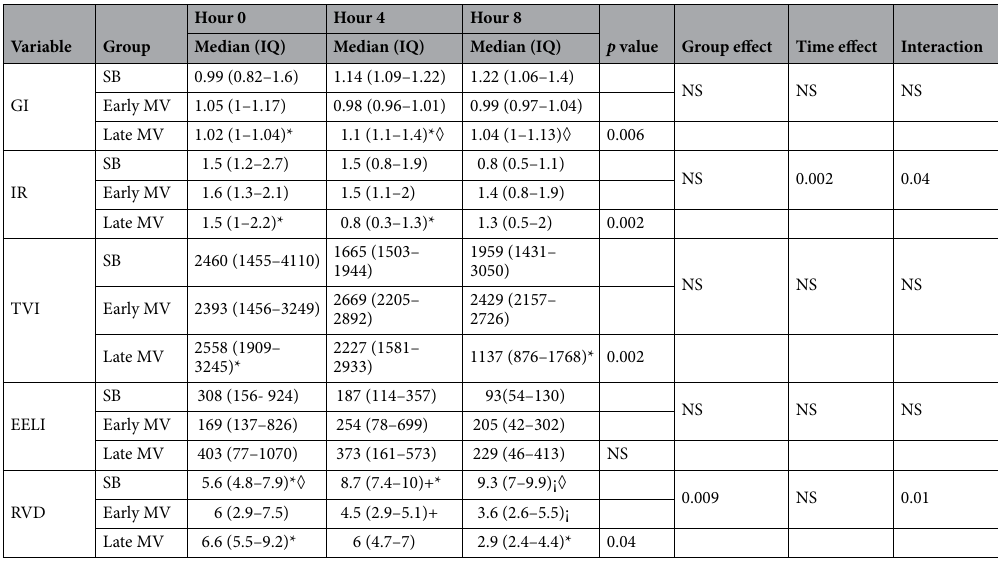
Table 4. EIT parameters. p value corresponds to Friedman test to the Late MV group, (* and ◊) correspond to p < 0.05 for multiple comparisons. The interaction, group effect, and time effect were estimated between SB and Early MV groups, using the GLMM for each variable. Posthoc analysis was done using the Tukey test. The uppercases * and ◊, denote p < 0.05 in pairwise comparisons time within each group. The “+” and “¡” signs denote p < 0.05 in pairwise comparisons between groups. GI: global inhomogeneity index, IR: impedance ratio, TVI: tidal variation of impedance, EELI: end-expiratory lung impedance, RVD: regional ventilation delay.